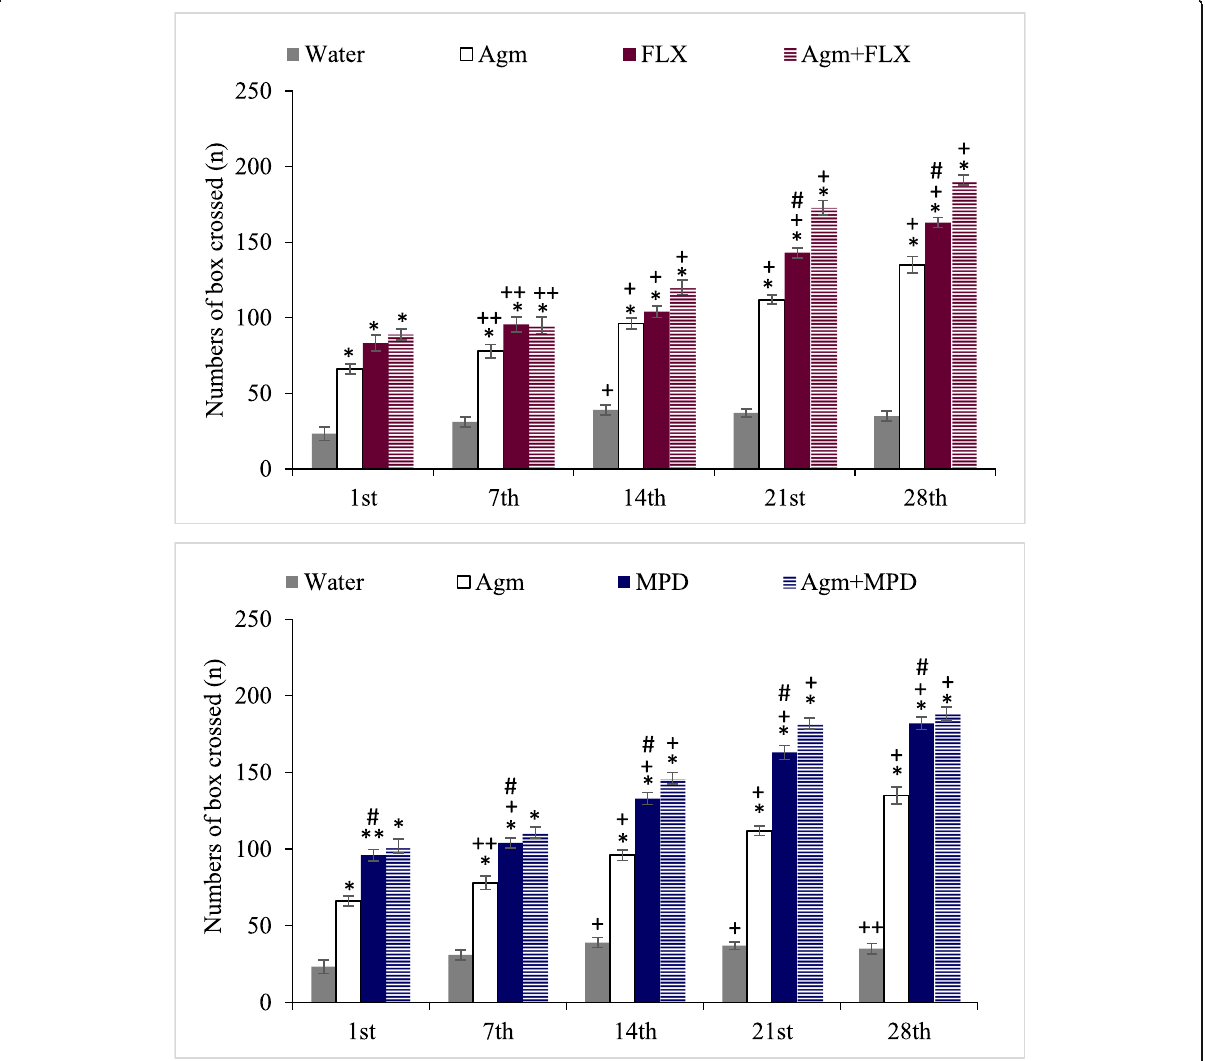
Fig. 9 Open field test: values are expressed as means ± SD ( n =6). Significant differences by Newman-Keuls test: * p <0.01, ** p <0.05 from water- treated control group to drug-treated groups. + p <0.01, ++ p <0.05 from drug ’ s 1st administration. # p <0.01, ## p <0.05 from AGM-treated animals